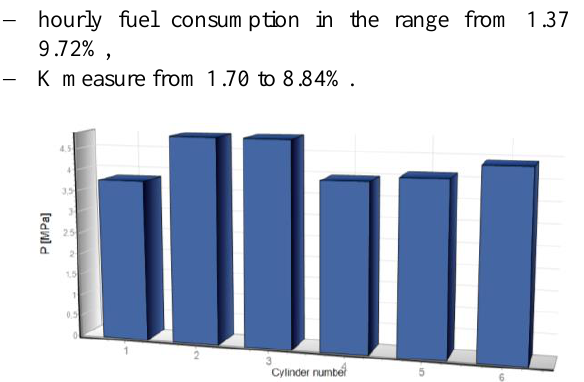
Fig. 5. The values of the maximum indicated pressure for the engine working with the crankshaft rotational speed of 450 rpm, and the load of